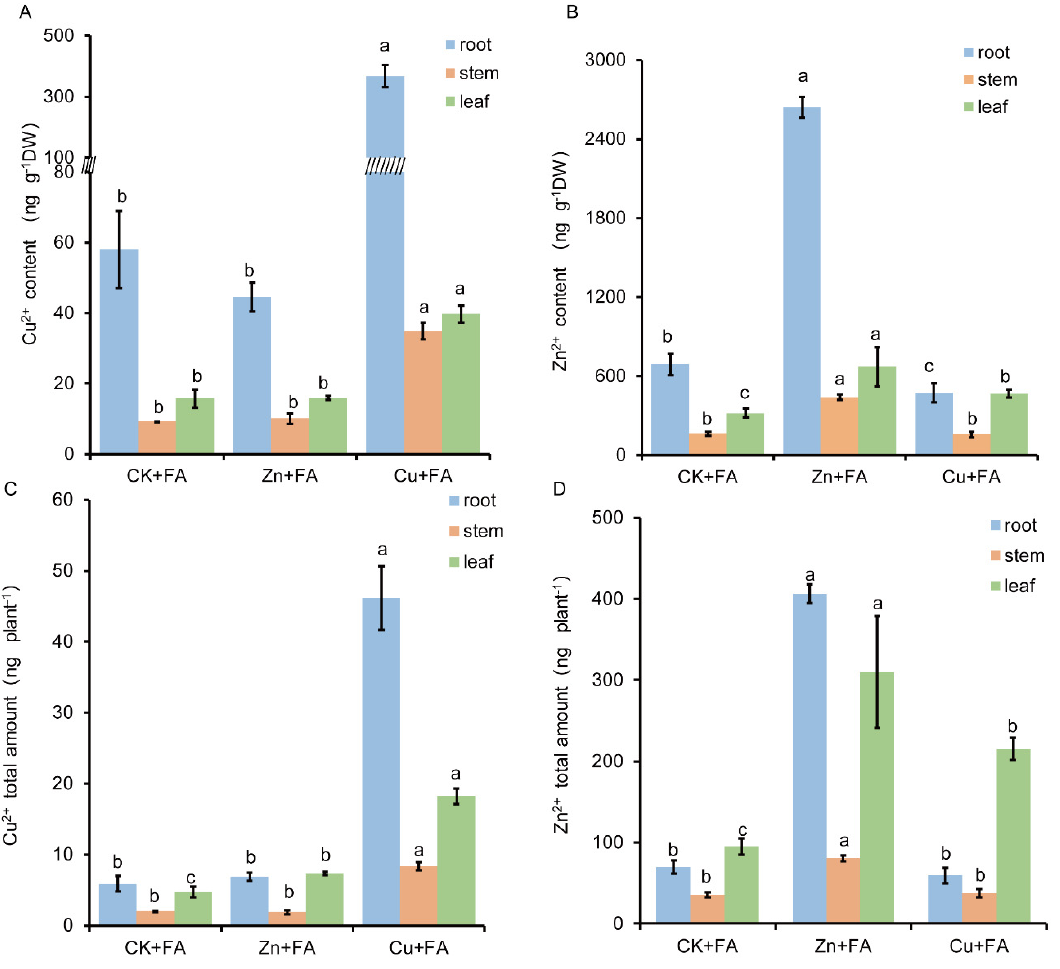
Figure 3. Relationship between Cu 2+ and Zn 2+ distribution and the FA distribution. Cu 2+ or Zn 2+ content ( A , B ) and amount ( C , D ) of cucumber plant issues treated with fusaric acid (FA). Bars represent the standard deviation of three replicated each. Different letters indicate significant differences ( p < 0.05, Duncan’s multiple range test) of the same tissue among three treatments.